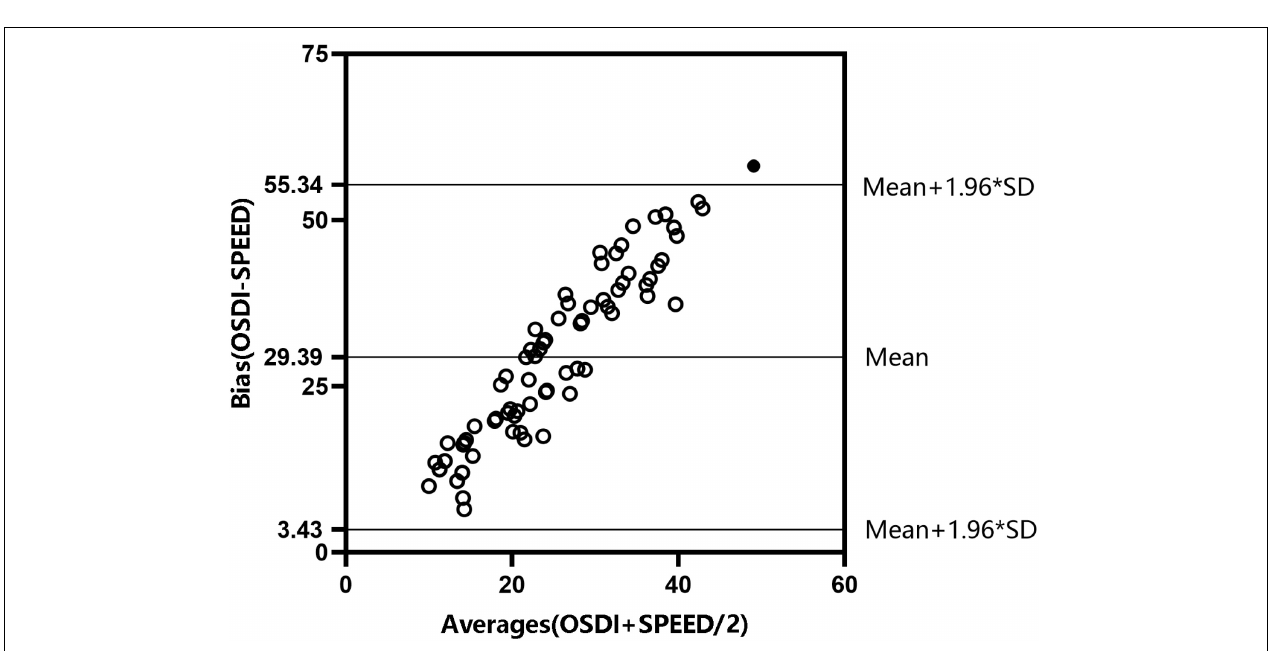
FIGURE 2 | Consistency test of Ocular Surface Disease Index (OSDI) and Standard Patient Evaluation of Eye Drynes (SPEED) questionnaire scores in patients with dry eye disease (DED) aged 41 − 65.